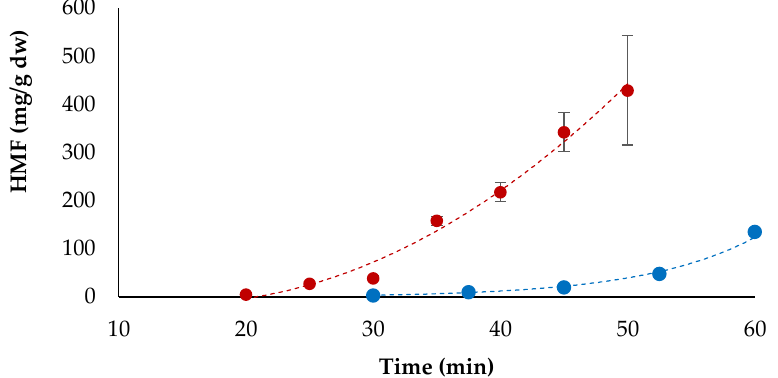
Figure 5. Evolution of 5-hydroxymethylfurfural (HMF) in bread baked at 200 °C ( ● ) and 225 °C ( ● ). Average of replicate trials, bars represent standard deviation .